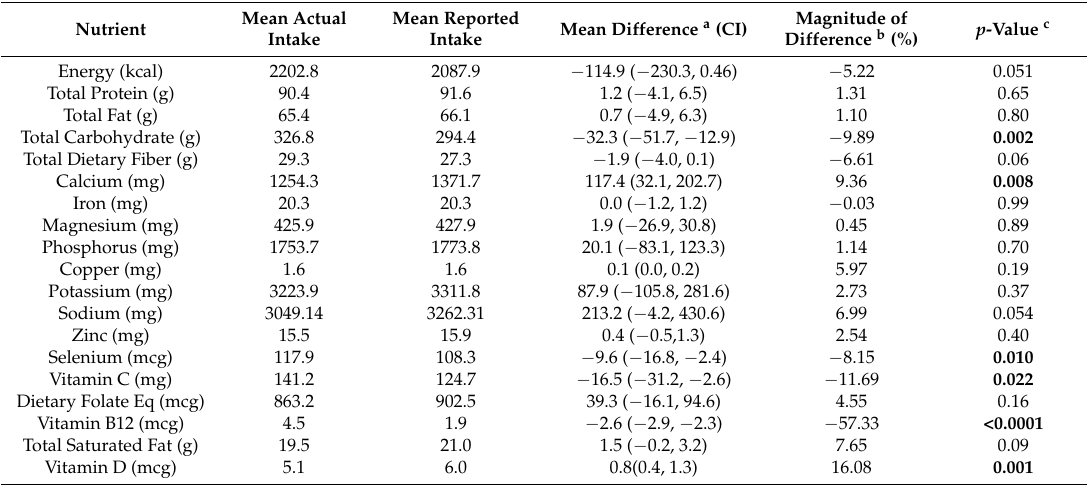
Table 5. Difference between actual and reported energy and nutrient intake using ASA24. Mean Actual Nutrient